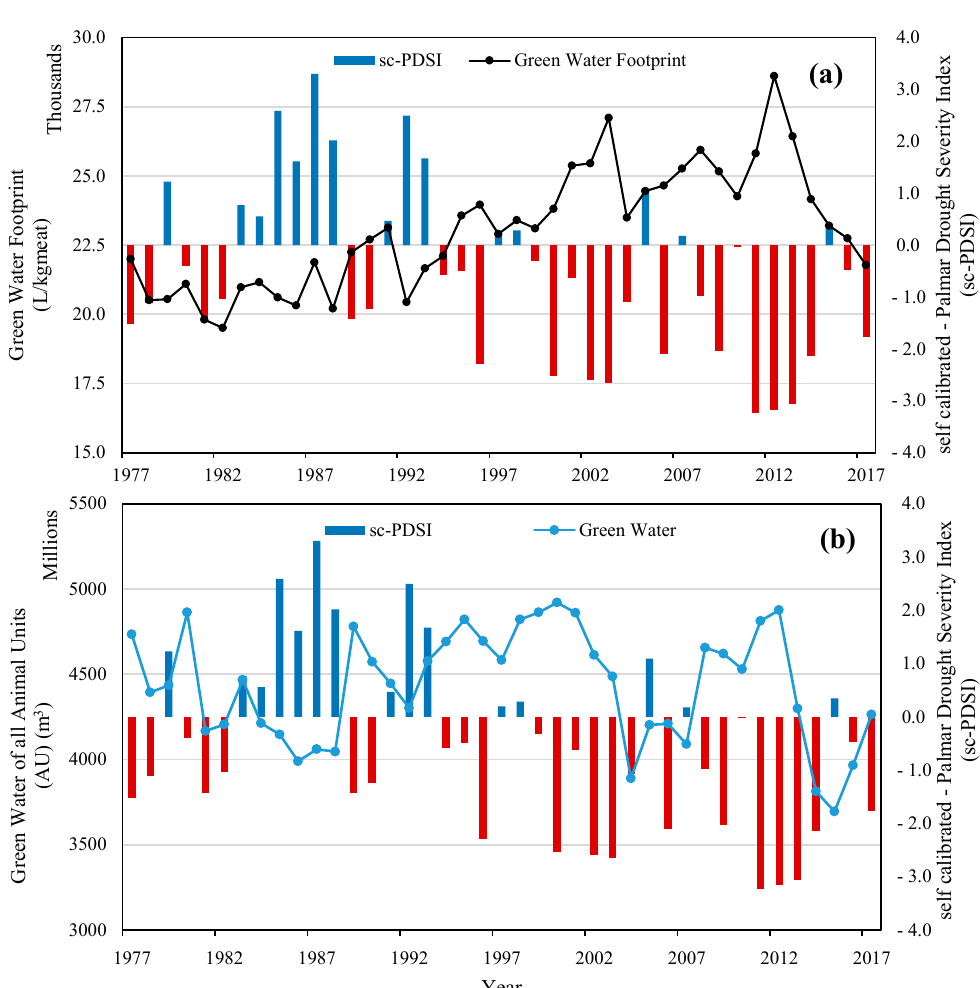
Figure 5. Comparison of drought based on the self-calibrated Palmer Drought Severity Index (sc-PDSI) and beef cattle ( a ) green water footprint (GWF) and ( b ) total green water consumption over New Mexico between 1977 to 2017.